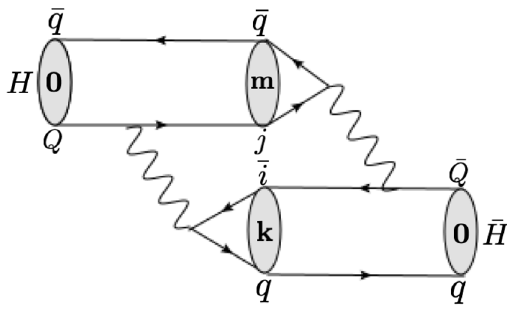
¯ H , where H consists of Q ¯ q . ( H, Q, ¯ q ) is taken as